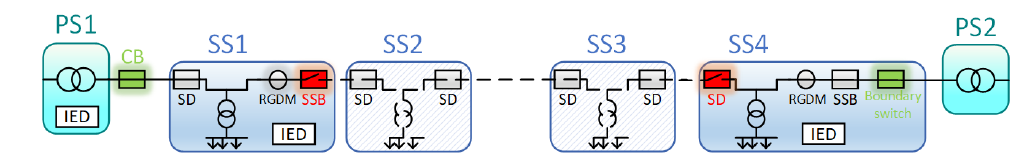
Figure 4. SFS approach with only two automated